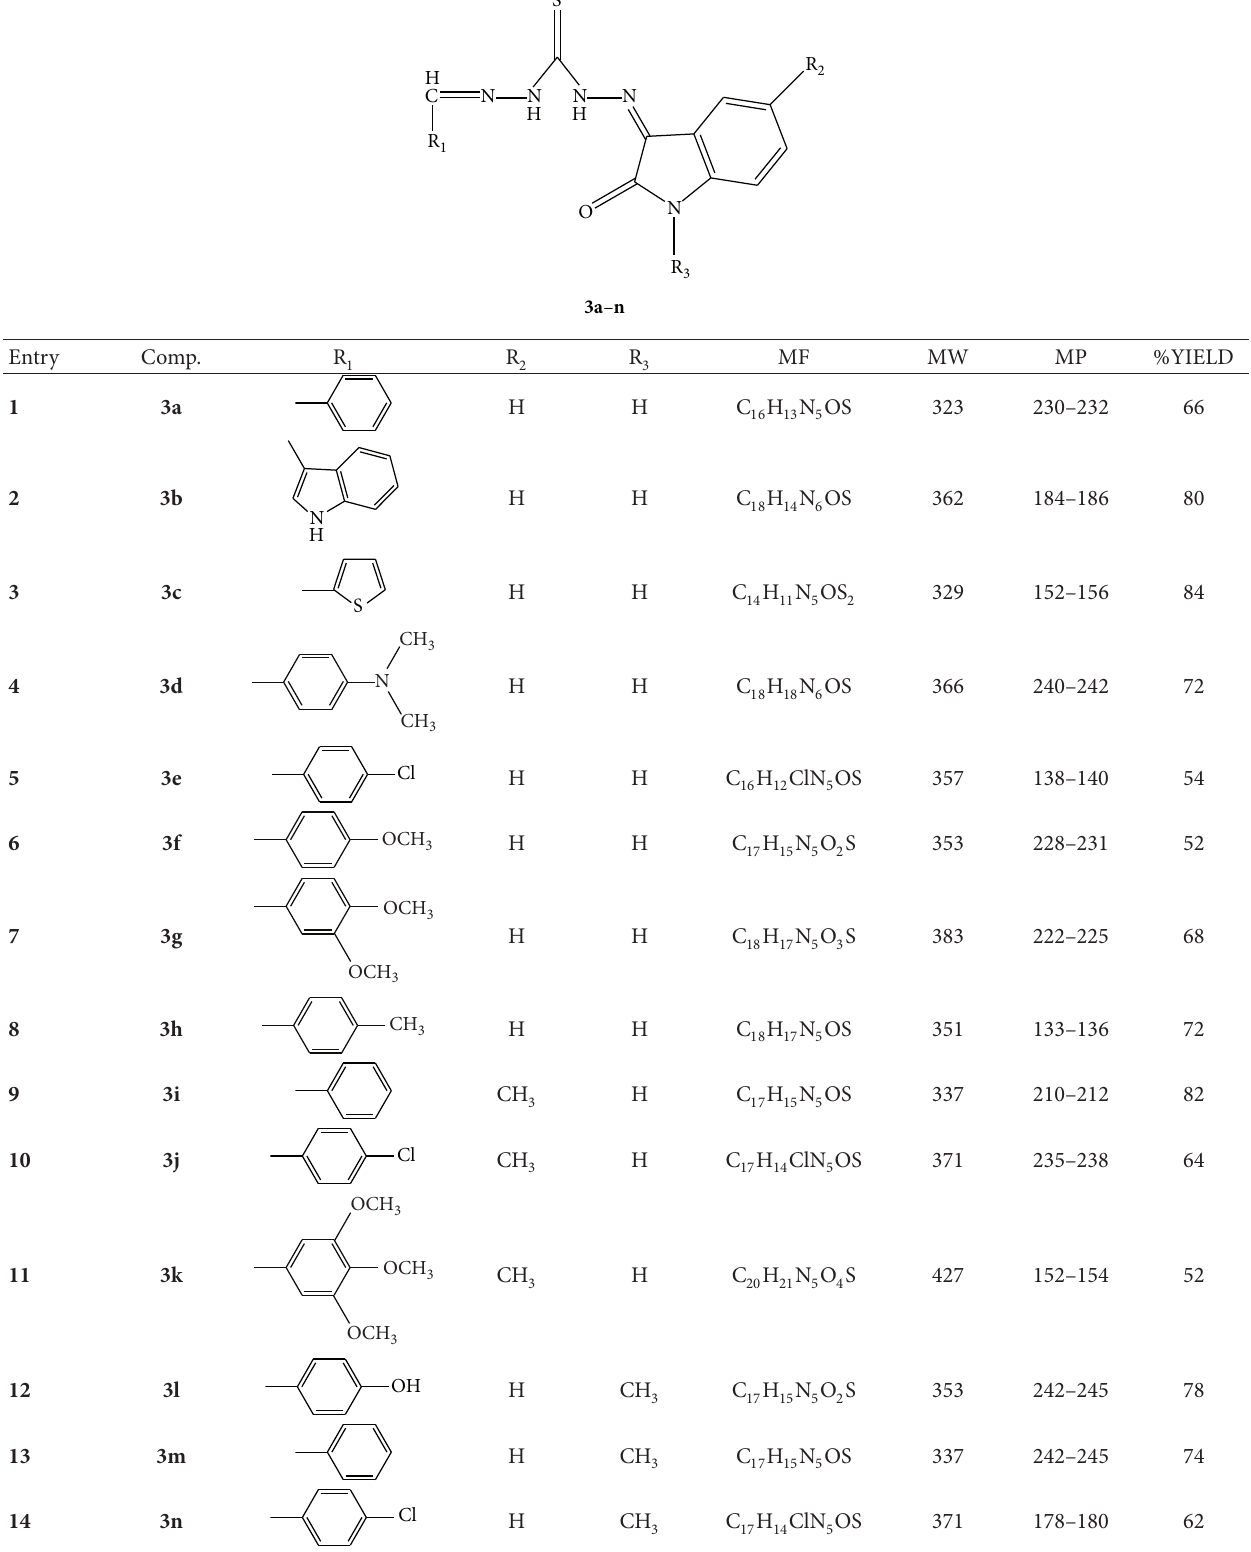
T 1: Physical data of all synthesized test compounds (3a–n)